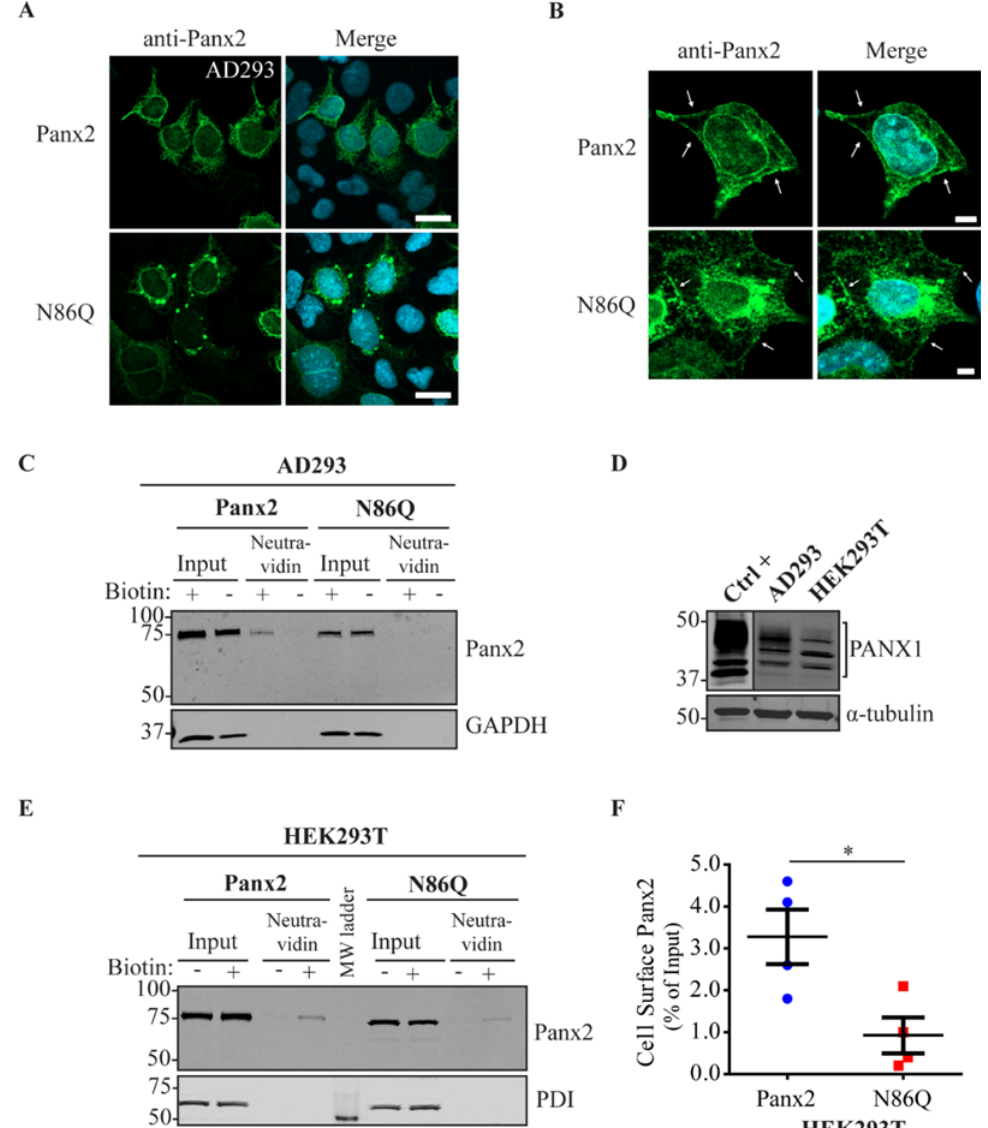
Figure 3. Analysis of Panx2 and N86Q localization in AD293 and HEK293T cells expressing endogenous PANX1. ( A ) Immunolabeling of Panx2 and N86Q mutant (green) showed that both localized mostly intracellularly, but the N86Q mutant aggregated intracellularly in AD293 cells. Scale bars = 20 µ m. ( B ) A subpopulation of AD293 cells displayed Panx2 localization at the cell surface, less evident with the N86Q mutant (indicated with white arrows) Scale bars = 5 µ m. Nuclei (blue). ( C ) Cell Surface Biotinylation Assays on AD293 cells showed a weak detection of the Panx2 wildtype but not N86Q mutant in surface-labeled fractions. GAPDH was used as a control for biotin internalization. ( D ) Immunoblots of AD293 and HEK293T cells confirmed that both cell lines express endogenous PANX1. Overexpressed human PANX1 served as positive control (Ctrl +) and endogenous α -tubulin was used as loading control. Line dividing upper panel of PANX1 WB indicates differences in exposure of the same blot to show a better detection of endogenous PANX1 compared to the overexpressed positive control. ( E ) Cell surface biotinylation experiments performed on HEK293T cells showed that overexpressed Panx2 and the mutant N86Q are detectable at the cell surface. Protein disulfide-isomerase (PDI) was used as a control for biotin internalization. ( F ) Densitometric analysis and quantification of cell surface biotinylation experiments performed in HEK293T cells revealed a significant reduction of N86Q cell surface detection compared to Panx2. Cell surface detection was calculated relative to the total protein in input lanes. Statistical significance was considered when p < 0.05 (* p = 0.0286, N = 4 independent experiments), Mann Whitney U test. Error bars denote mean ± S.E.M. Molecular weights are noted in